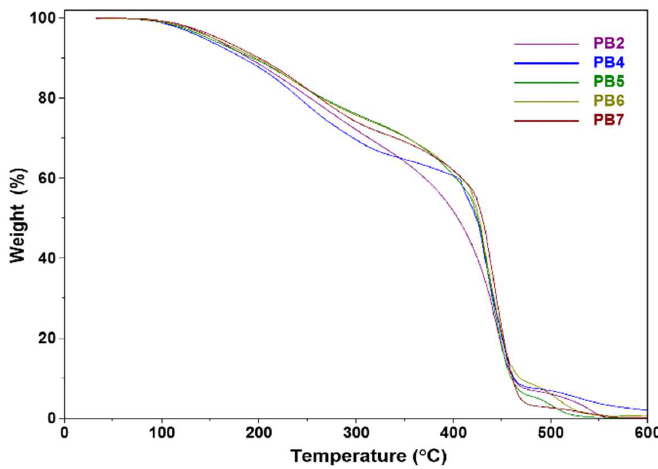
Figure 7. TGA thermograms of biobased HTPB obtained by metathesis degradation during the catalyst optimization.